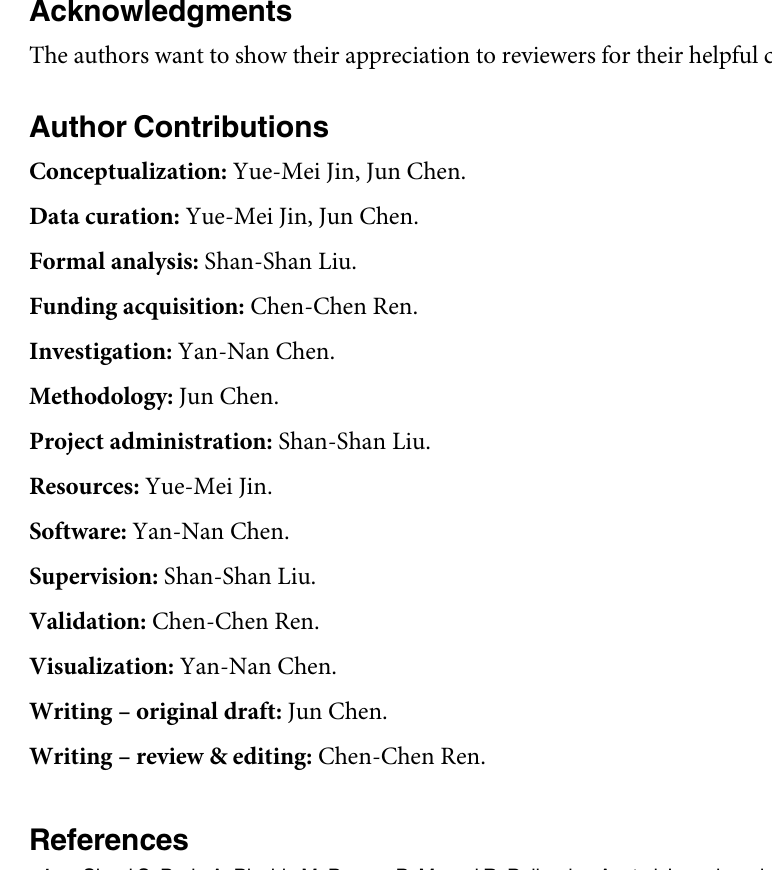
S5 Fig. Relative relationship forest plots of operative time (min), number of pelvic lymph nodes removed and intraoperative complications of RRH, LRH and ORH in the treatment of early-stage CC. Note: A = RRH (robotic radical hysterectomy); B = LRH (laparoscopic radi- cal hysterectomy); C = ORH (open radical